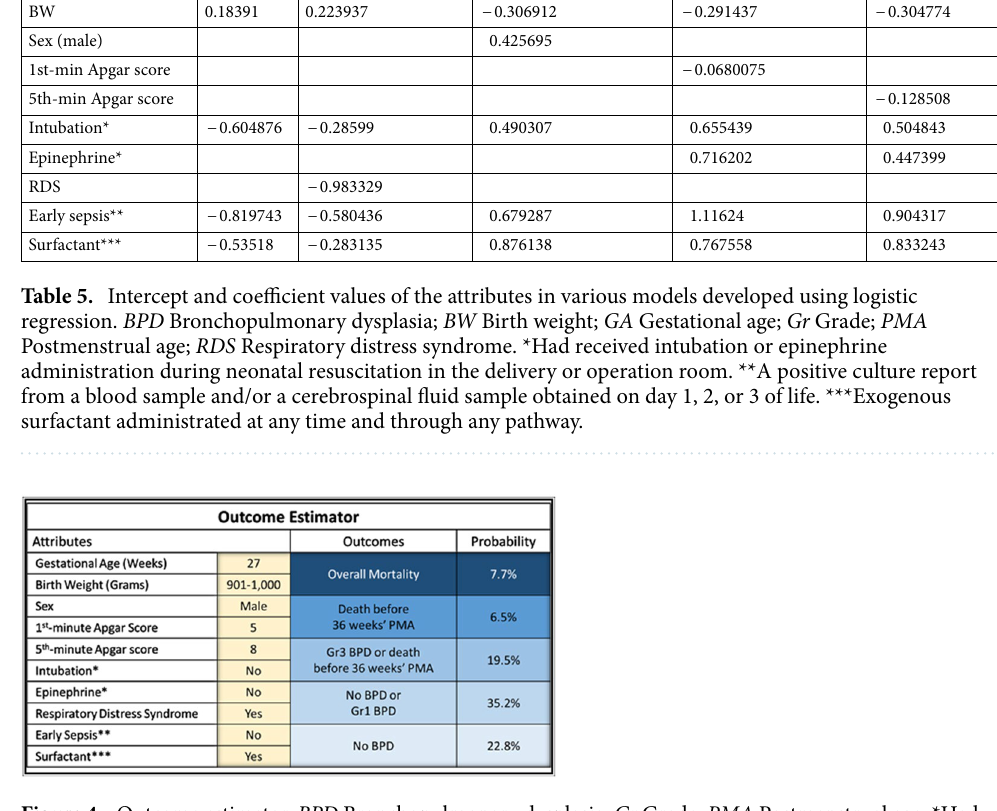
Figure 4. Outcome estimator. BPD Bronchopulmonary dysplasia; Gr Grade; PMA Postmenstrual age. *Had received intubation, epinephrine administration, or chest compression during neonatal resuscitation in the delivery or operation room. **A positive culture report from a blood sample and/or a cerebrospinal fluid sample obtained on day 1, 2, or 3 of life. ***Exogenous surfactant administered at any time or through any